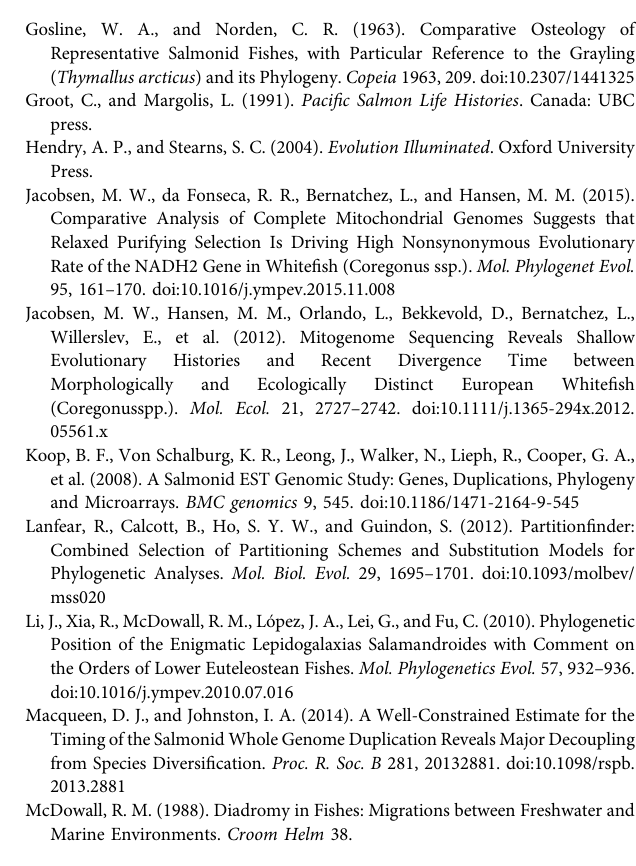
Supplementary Figure S1 | Saturation tests for any codon position in the concatenated